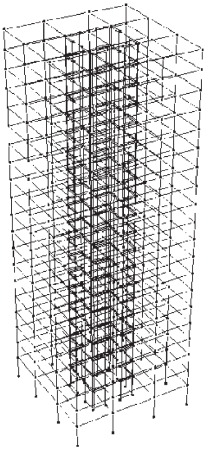
Figure 10: Structure model.